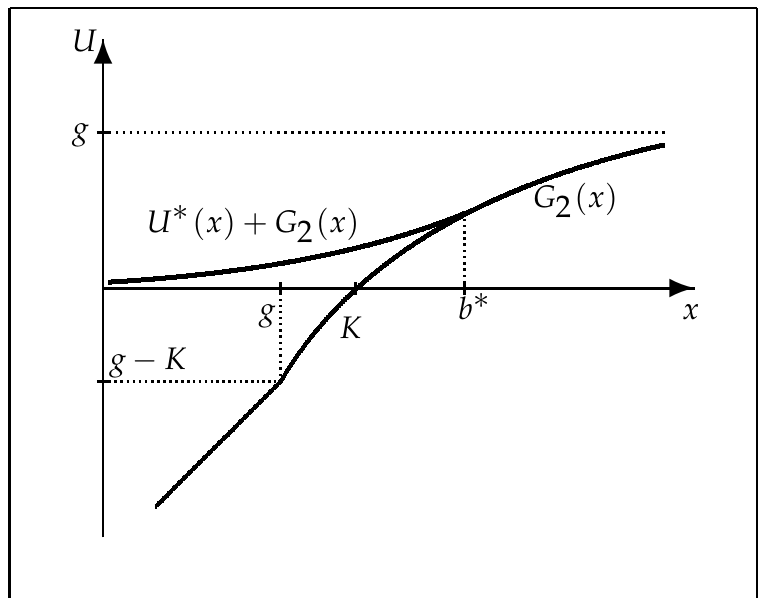
Figure 2. A computer drawing of the value function U ∗ ( x ) + G 2 ( x )